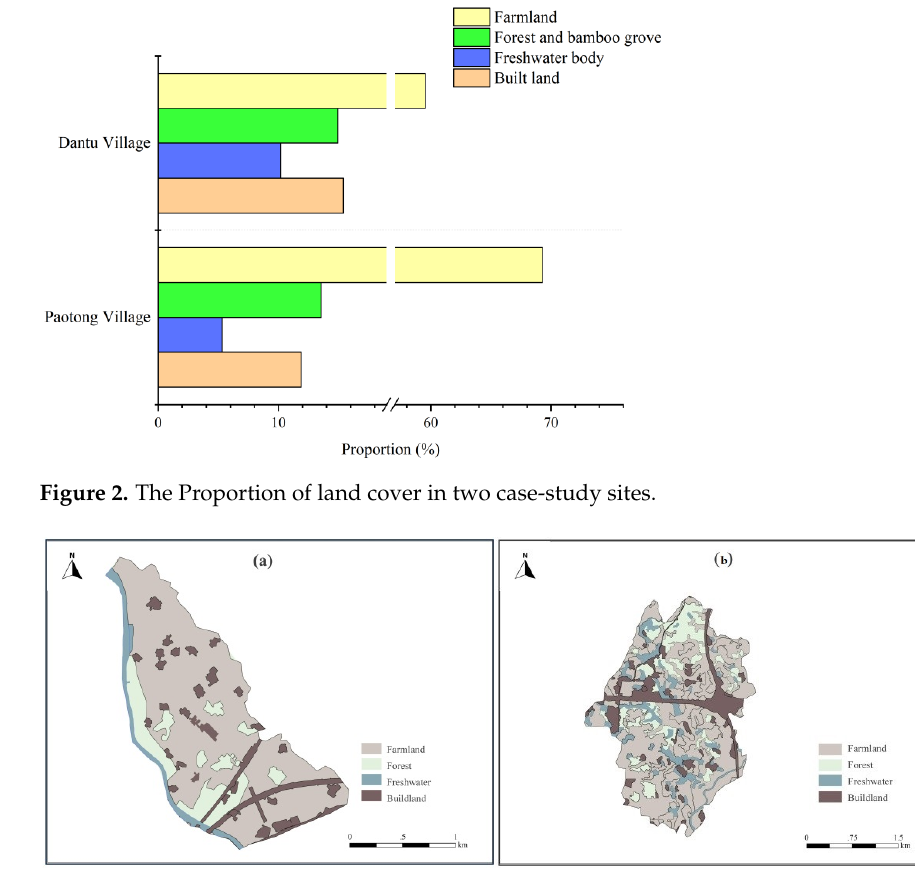
Figure 3. Land use of Paotong Village ( a ) and Dantu Village ( b ).